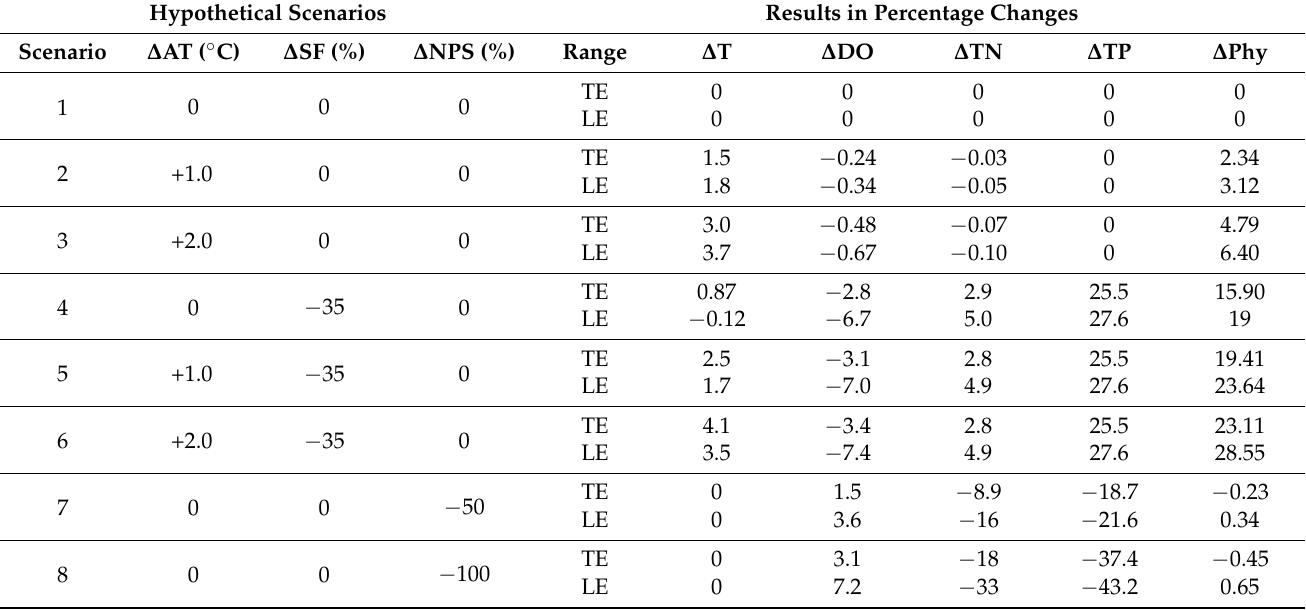
Table 4. Scenarios investigated and percentage changes in water temperature (T), DO, TN, and TP concentrations, and phytoplankton concentration under the hypothetical scenarios for the total estuary (TE) and the lower estuary